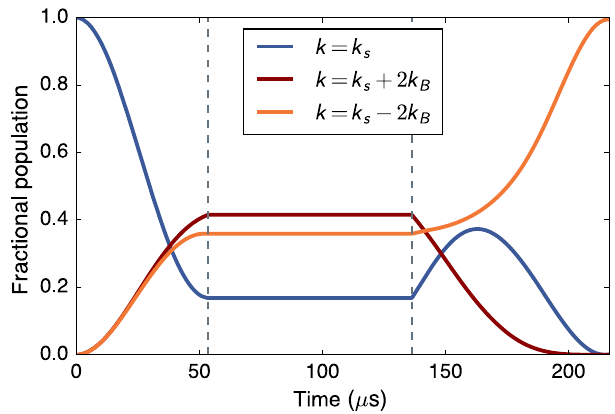
FIG. 15. Thermalization distance of synthesized symmetric distributions generated by adding to the single-sided distributions shown in Fig. 14 their own mirror images. The blue horizontal during s i line is the mean noise floor, and the light blue band represents its 1 σ